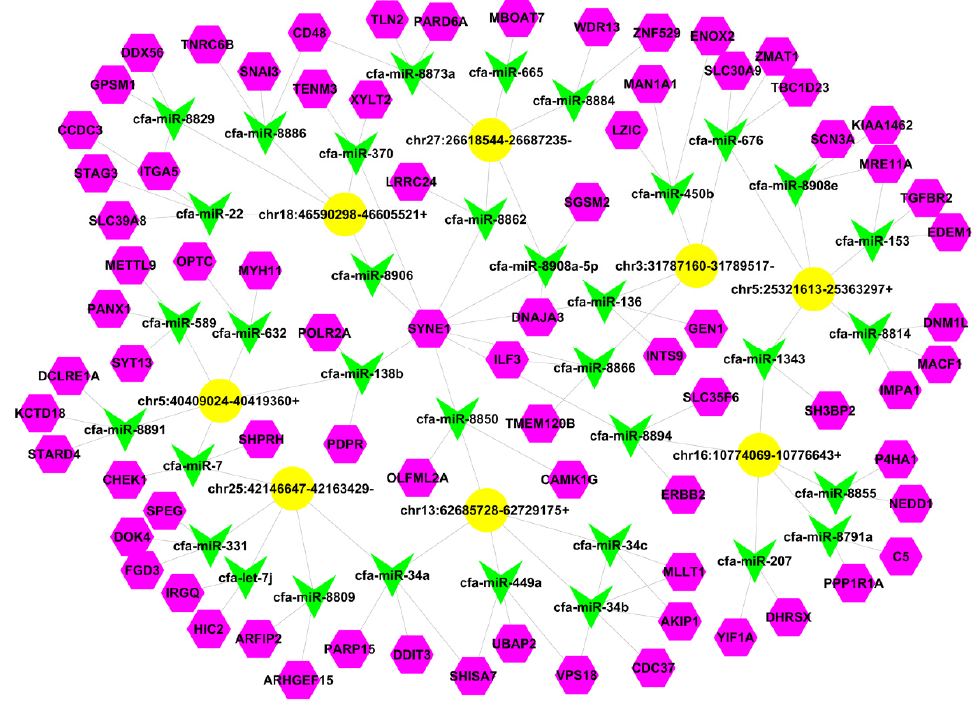
Figure 5. The molecular interaction of eight circRNAs and miRNAs. Yellow represents circRNAs, green represents miRNAs, and purple represents miRNA target genes.